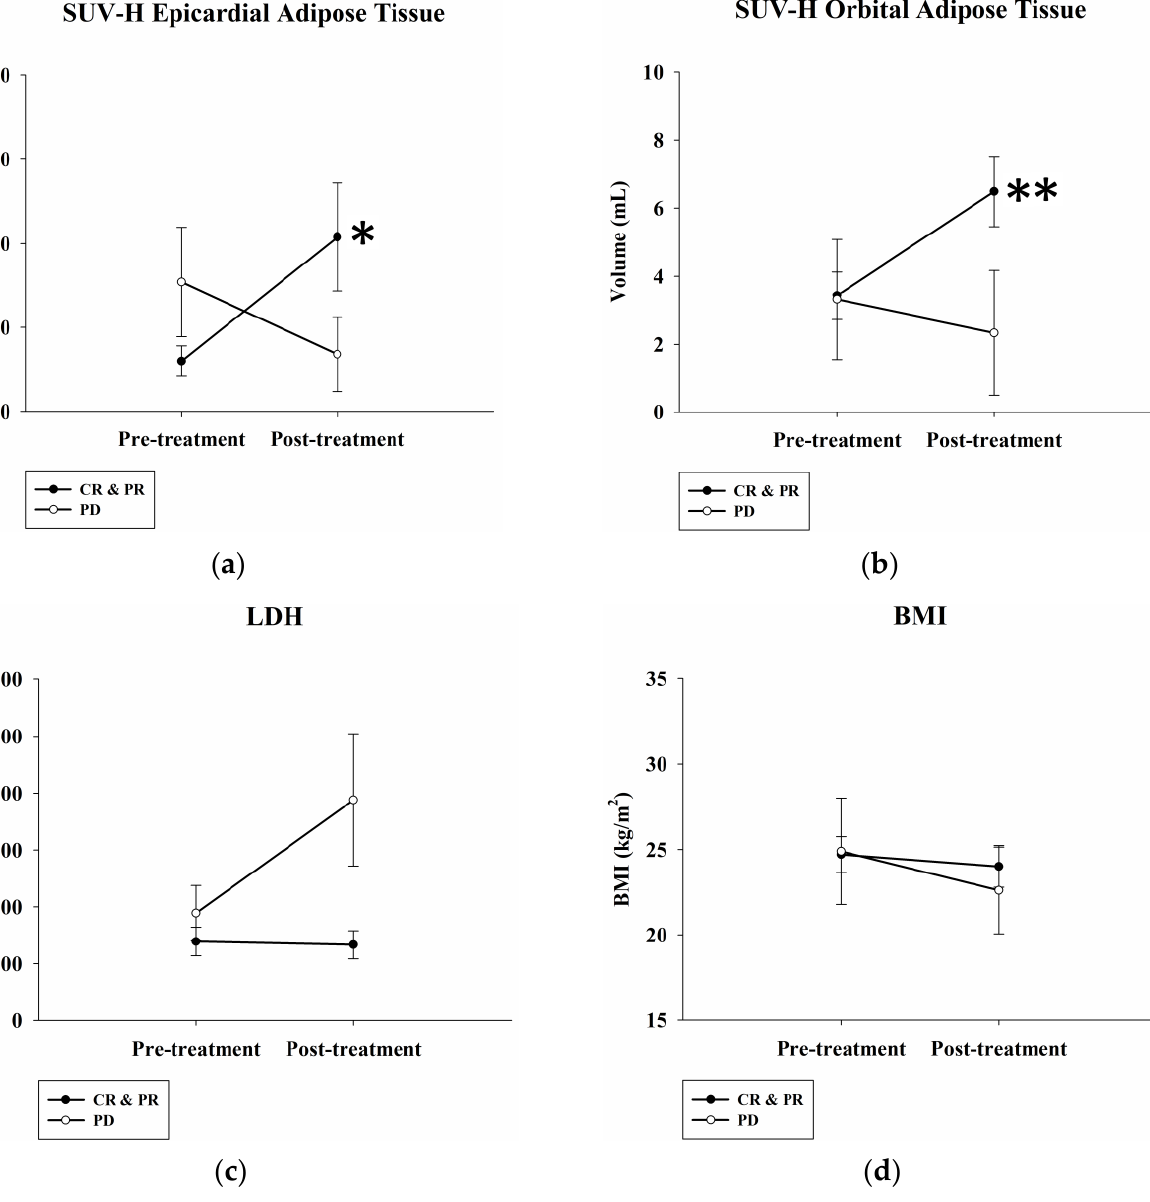
Figure 2. Pre- and post-treatment SUV-H EAT, OAT volume, serum LDH levels, and BMI, according to different treatment responses. ( a ) The SUV-H EAT volume significantly increased in responders ( p = 0.03) but decreased in non-responders ( p = 0.32). ( b ) The SUV-H OAT volume significantly increased in responders ( p = 0.002) but decreased in non-responders ( p = 0.19). ( c , d ) There were no significant differences between pre- and post-treatment serum LDH levels or BMI among responders versus non-responders. * Differences are significant at the 0.05 level (two-tailed). ** Differences are significant at the 0.01 level (two-tailed). SUV-H EAT, high standardized uptake value epicardial adipose tissue; SUV-H OAT, high standardized uptake value orbital adipose tissue; LDH, lactate dehydrogenase; BMI, body mass index; CR, complete response; PR, partial response; PD, progres- sive disease.